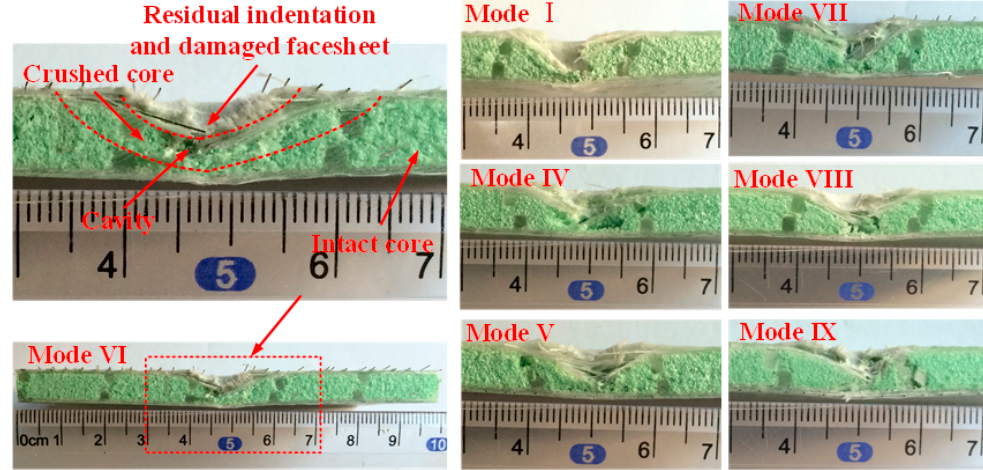
Figure 6. The transverse damage morphology of representative impacted sandwich panels.